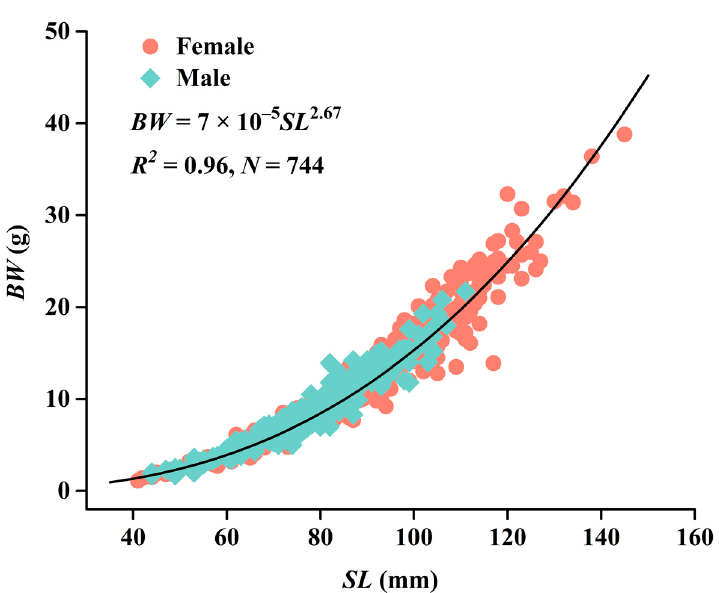
Figure 3. Relationship between body weight ( BW ) and standard length ( SL ) of G. tibetana in the lower Yarlung Tsangpo River.